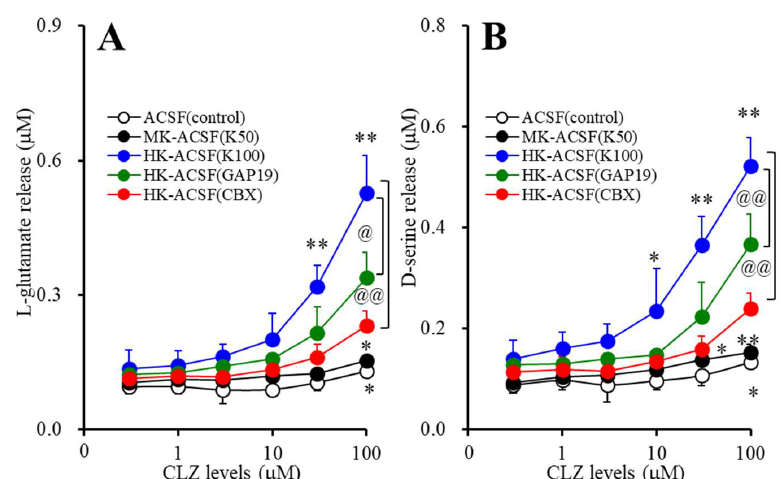
Figure 1. Concentration-dependent effects of acute administration of CLZ (clozapine) on basal and K + -evoked astroglial releases of L -glutamate ( A ) and D -serine ( B ). After wash-out, astrocytes were incubated in 100 μL ACSF (artificial cerebrospinal fluid) containing CLZ (0, 1, 3, 10, 30, or 100 μM) for 60 min (pretreatment incubation). After pretreatment incubation, to determine the K + -evoked astroglial releases of L-glutamate and D-serine, astrocytes were incubated in ACSF (3.0 mM K + : opened circles), MK-ACSF (50.0 mM K + : closed circles) or HK-ACSF (100.0 mM K + : blue circles) containing the same concentration of CLZ of pretreatment incubation for 20 min. To clarify the astroglial releases of L-glutamate and D-serine associated with Cxs (connexin (Cx) composed transmembrane channels), astrocytes were incubated in HK-ACSF containing GAP19 (TAT-conjugated Gap19, 20 µ M) (green circles) or CBX (carbenoxolone, 100 μ M) (red circles) with the same concentration of CLZ during pretreatment incubation for 20 min, and then incubation medium (ACSF, MK-ACSF or HK-ACSF) was collected for analysis. Ordinate: mean±SD ( n = 6) of extracellular levels of L -glutamate and D -serine (μM). Abscissa: concentration of CLZ ( μ M). * p < 0.05 and ** p < 0.01 vs. CLZ free by MANOVA with Tukey’s post hoc test. @ p < 0.05 and @@ p < 0.01 vs. HK-ACSF by MANOVA with Tukey’s post hoc test.